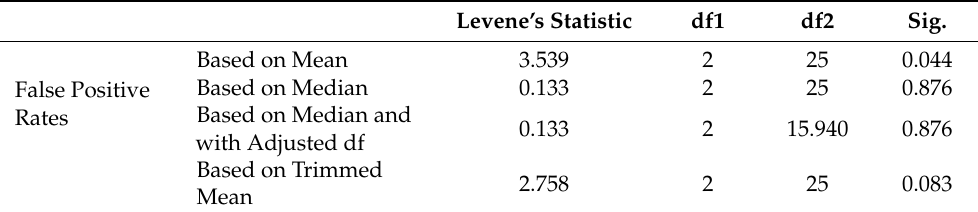
Table 4. Levene’s test of equality of error